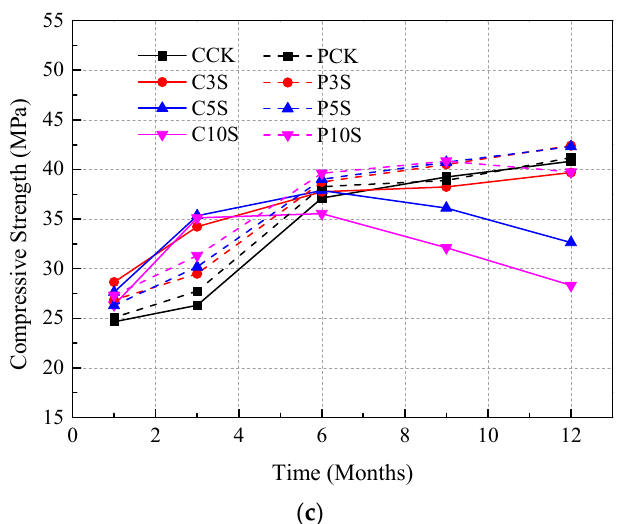
Figure 7. Compressive strength of concrete with different water/cement ratios: ( a ) 0.40, ( b ) 0.48, and ( c ) 0.55.